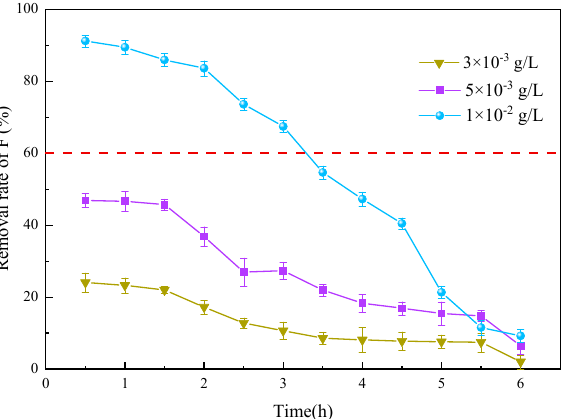
Figure 15. Effect of initial F − concentration in an adsorbent column. The pH was set to 7. The flow speed was set to 4 mL/min.